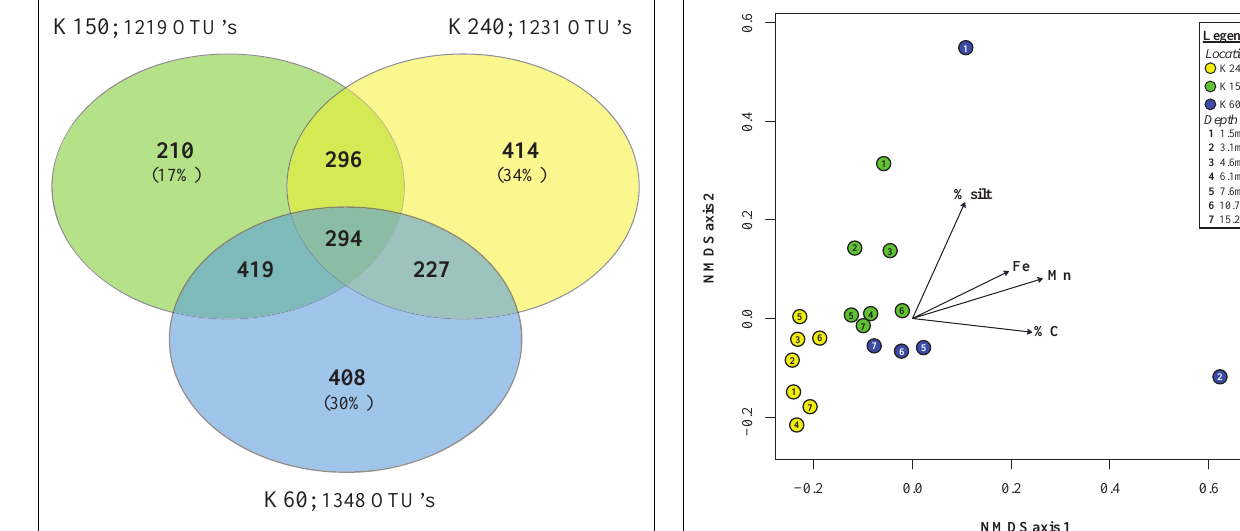
FIGURE 5 |As shown in theVenn diagram, a greater percentage of the OTUs present within the bacterial communities at well locations K240 (village) and K60 (river) were unique than at well K150 (mid flow path). In addition, K150 and K60 shared a greater percentage of OTUs (approximately 30%).